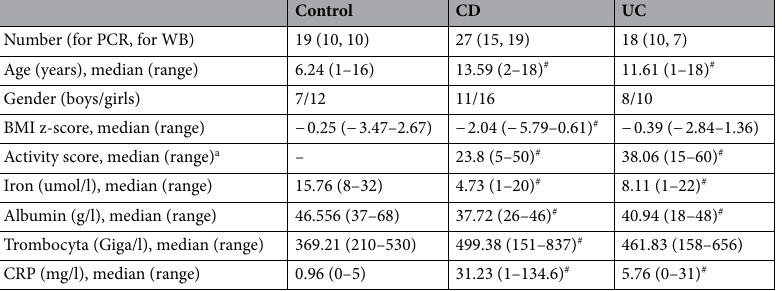
Table 1. Clinical characteristics of the study population in the Control, Crohn’s Disease (CD) and Ulcerative Colitis (UC) groups. BMI body mass index, CRP C-reactive protein. a Activity score: CD/UC Activity Index. # p < 0.05 vs .